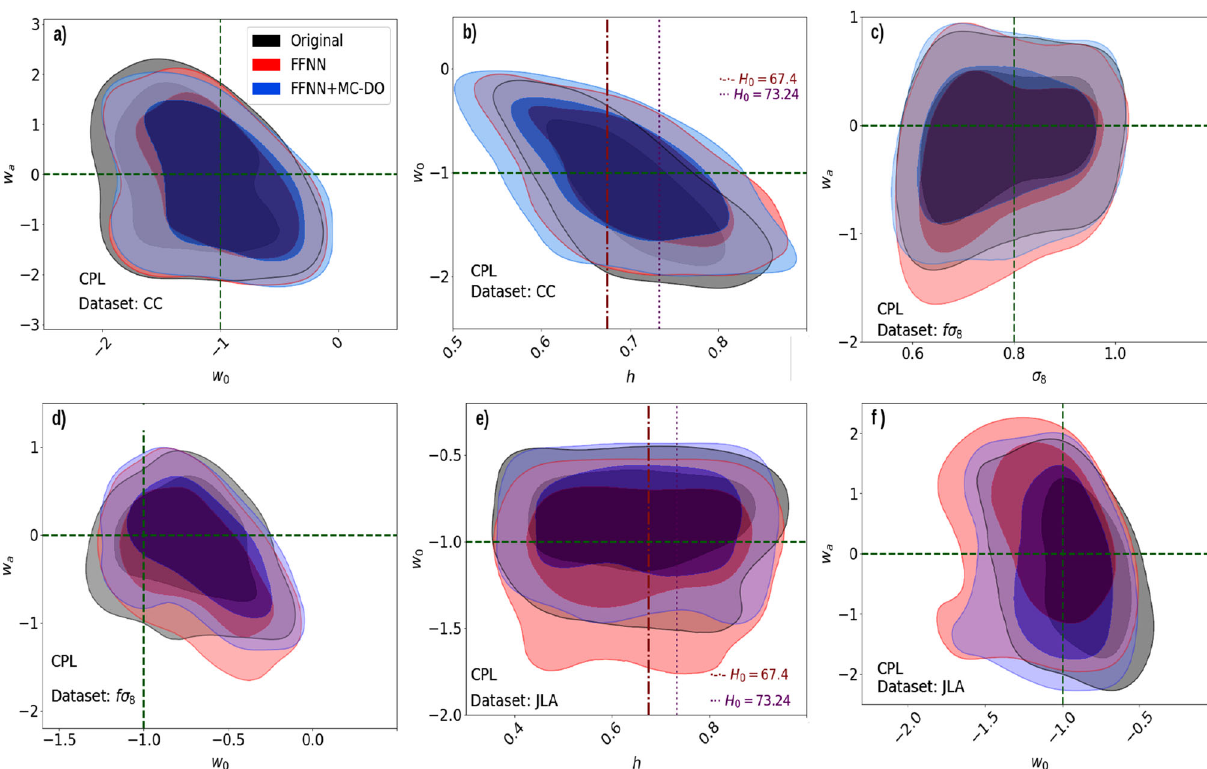
Fig. 6 2D marginalized posterior distributions from different com- binations of datasets: original data, reconstructions data points from FFNNandFFNN+MC-DO.Thegreendashedlines( w 0 = − 1, w a = 0)